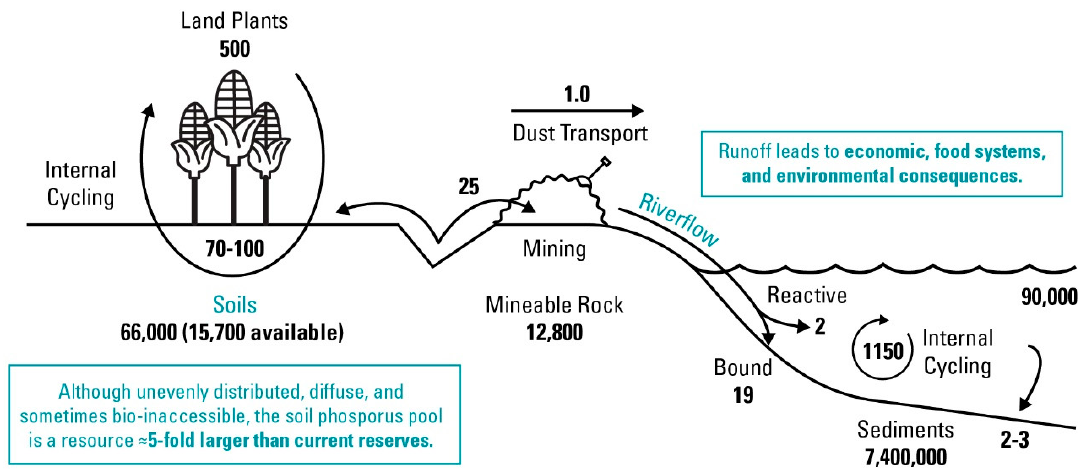
Figure 1. Global phosphorus flows with flux shown in units of 10 12 g P / year. Recreated from [15] .